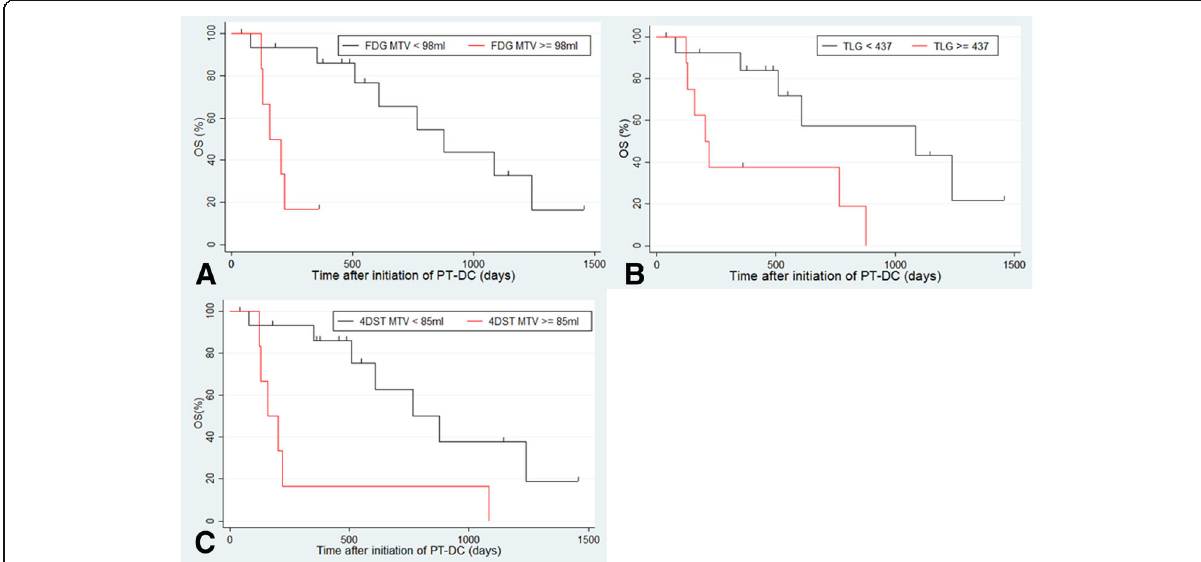
Fig. 3 Kaplan-Meier analysis for overall survival (OS) in patients with advanced non-small-cell lung cancer treated with platinum-based doublet chemotherapy. (PT-DC). a OS according to metabolic tumor volume (MTV) of baseline FDG. b OS according to total lesion glycolysis (TLG) of baseline FDG. c PFS according to MTV of baseline